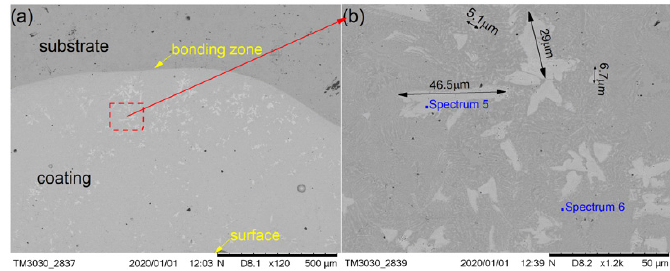
Figure6. SEMmorphologyofthecermetcoatingsat2800W:( a )lowmagnification; ( b Figure 6. SEM morphology of the cermet coatings at 2800 W: ( a ) low magnification; ( b ) high magnification.